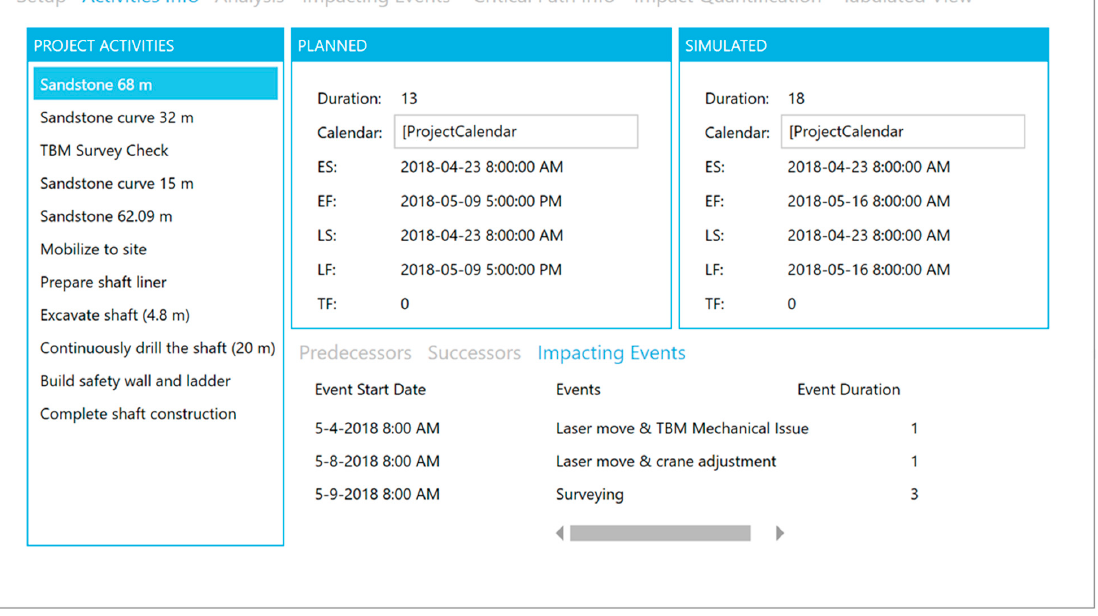
Figure 7. Simulated activities information for the tunneling segment.